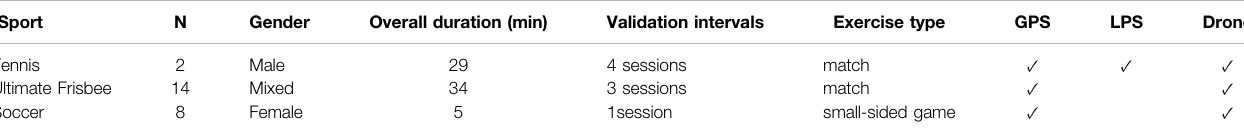
TABLE 1 | Description of the experimental design for tennis, Ultimate Frisbee and soccer, including the number of participants, gender, duration, match type, and tracking devices used. \Sport N Gender Overall duration